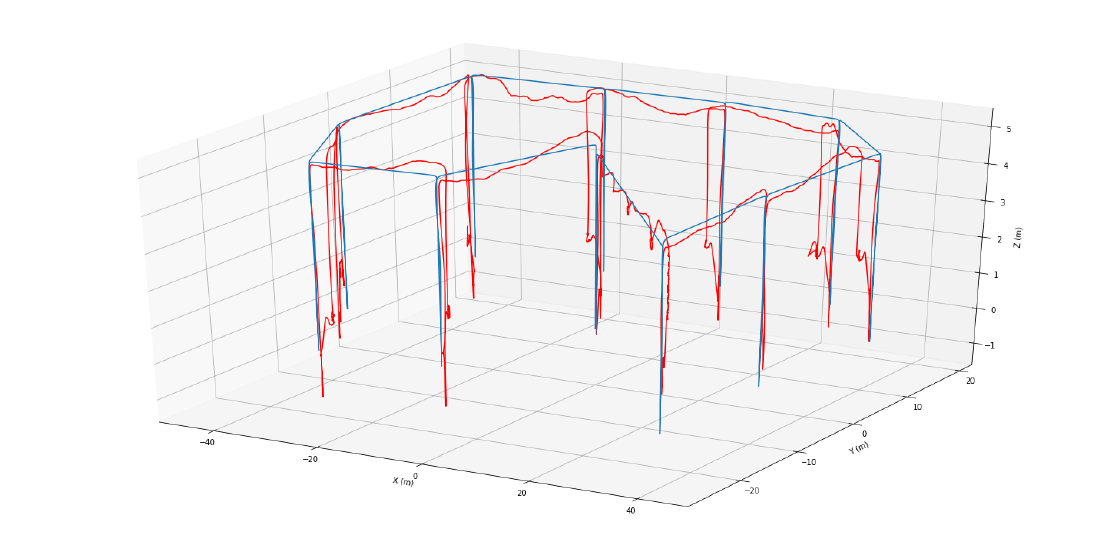
Figure 8. 3D Trajectory of the M100 compared against a reference